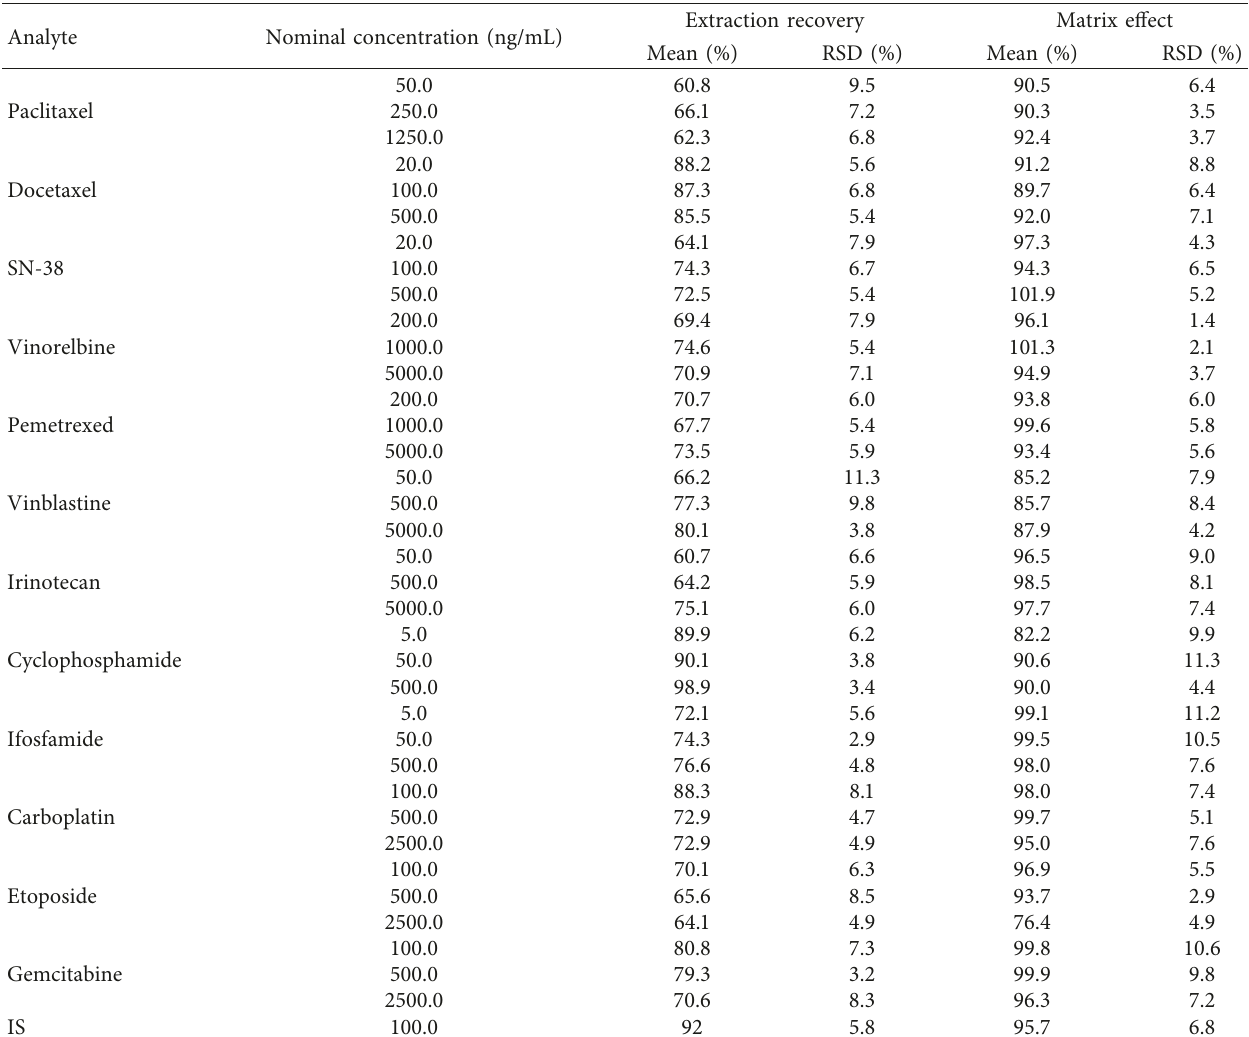
Table 3: Matrix effect and recovery of the analytes ( n � 3).